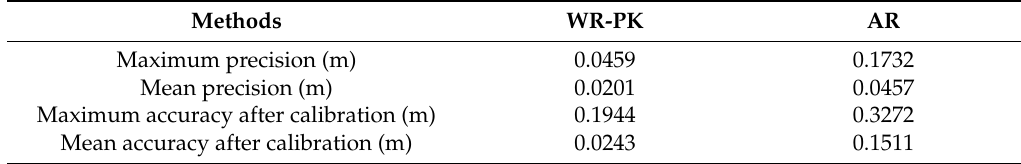
Table 1. The ranging accuracy and precision.